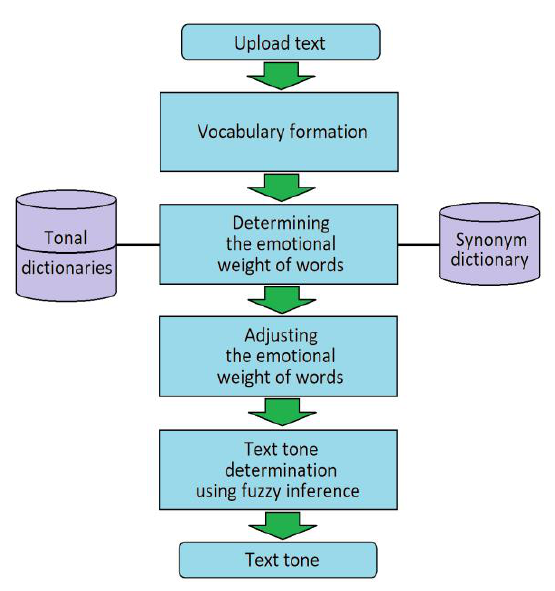
Fig. 1. Algorithm for determining the emotional tone of textual